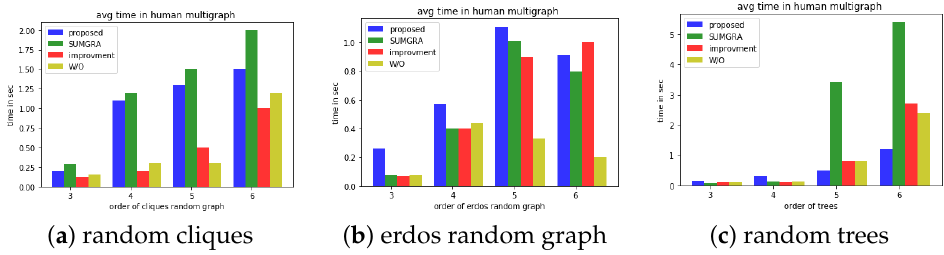
Figure 10. Query time on Human HIV4